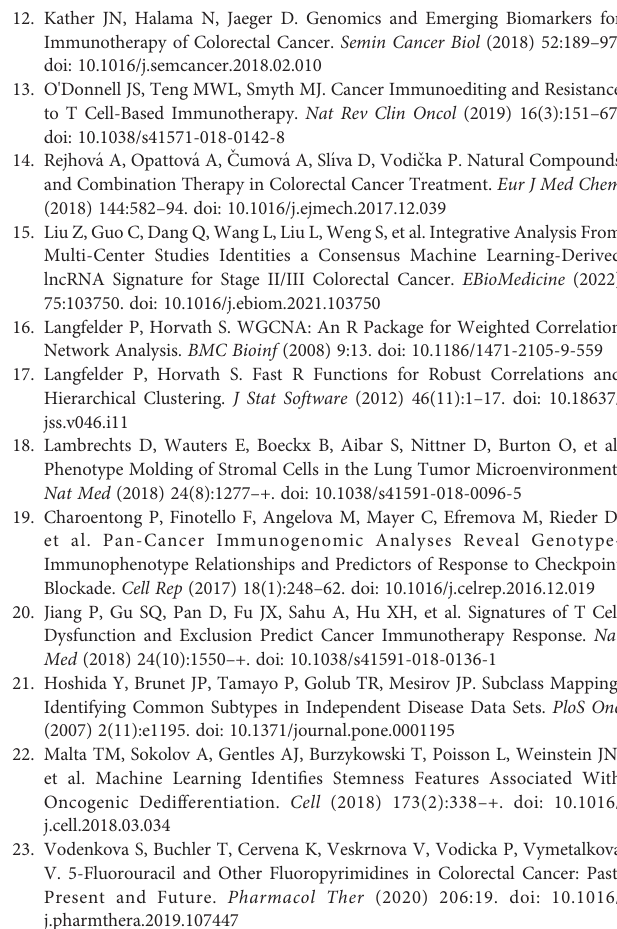
the adjacency matrix. (B) Thecorrelations between modules. (C) Univariate analysis with overall survival (OS) as the outcome event and the expression of the above 20 genes as independent variables. (D) Kaplan-Meier survival analysis of RFS cohorts from public portal. Supplementary Figure 2 | Prognostic analysis and ef fi cacy of predicting chemotherapy response. (A) Kaplan-Meier survival analysis of OS cohorts from public portal. (B) The receiver operating characteristic curve assesses the ef fi cacy of genes in predicting chemotherapy response in external and internal cohorts. (C) Differential expression of genes between chemotherapy-responsive and non-responsive groups in an internal cohort. Supplementary Figure 3 | Gene Mutation and Copy Number Variation Analysis. (A) Correlation analysis of TMB and SCG2 expression. (B) Differential analysis of the number of deletion and ampli fi cation mutations and TMB between high and low SCG2 expression groups. (C) Correlation analysis of neoantigen load and SCG2 expression. (D) Expression differences of SCG2 between mutation and non- mutation groups in top 30 FMGs. (E) A univariate logistic regression analysis of FMGs, which incorporated SCG2 expression as independent variable. (F) The association between the gain and loss loads with SCG2 expression at the arm level. (G) Univariate and multivariate logistic regression analysis revealed that SCG2 expression was an independent factor for all ampli fi ed genes mutation. Supplementary Figure 4 | Drug prediction. (A) CMap algorithm predicts drugs that may target SCG2 and ranks them by their speci fi city. (B) Mechanisms associated with the above